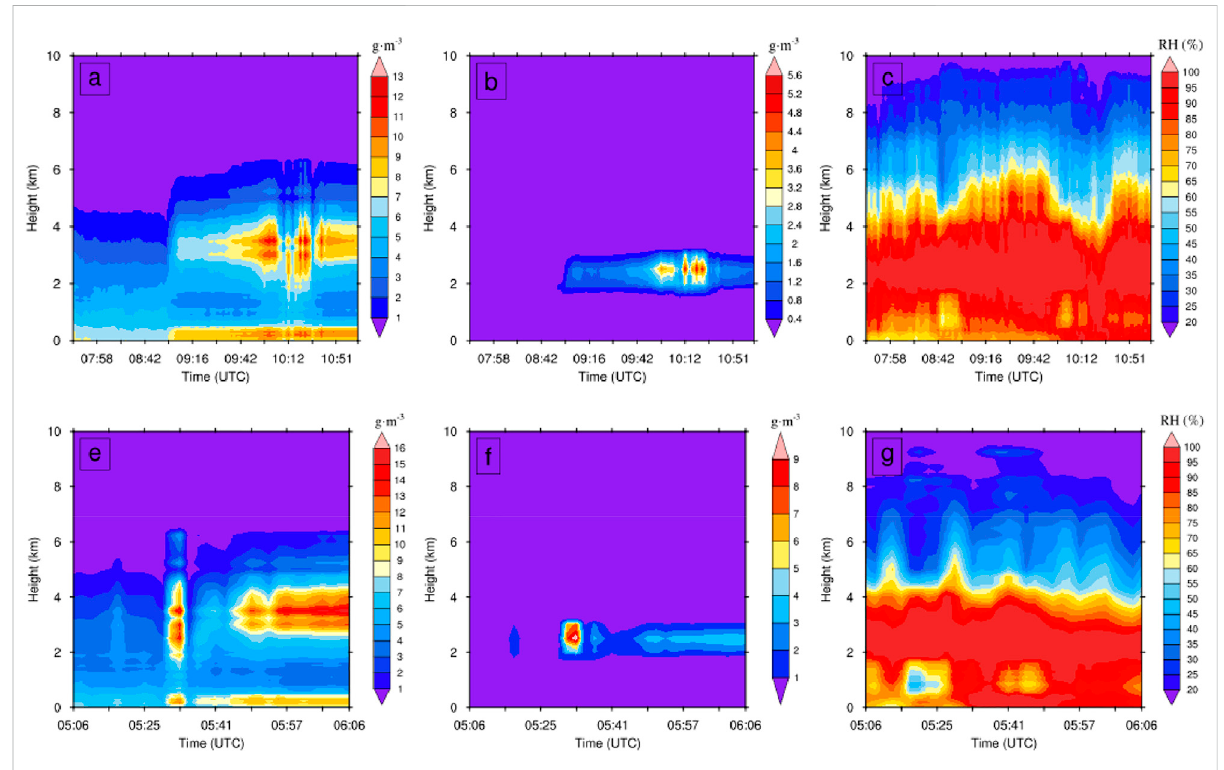
FIGURE 6 Time series of the vertical distribution of water vapor, liquid water, and relative humidity in PV thunderstorm (A,B,C) and in TC thunderstorm (E,F,G)